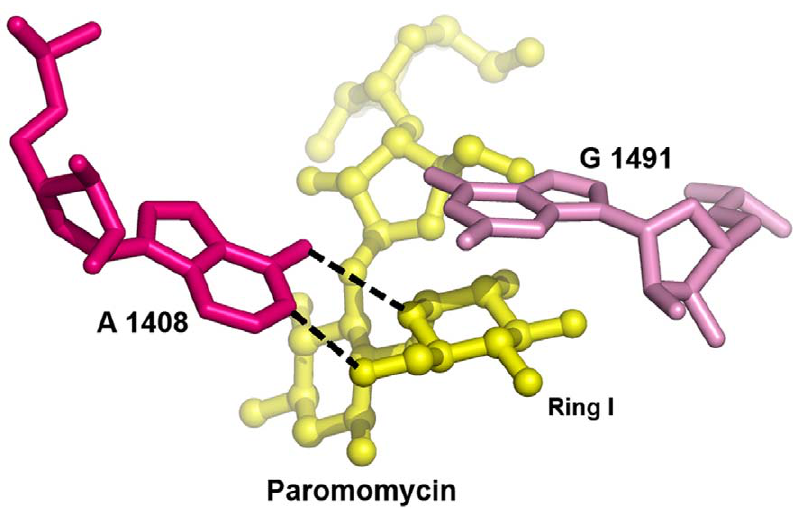
Figure 2. Secondary structure of 16S rRNA helix 44 in the ribosomal decoding site. ( A ) Decoding site of E. coli wild-type (Proteobacteria). Four nucleotide positions depicted in green represent residues that are specific for E. coli 16S rRNA. ( B ) Decoding site of M. smegmatis wild-type (Mycobacteria). ( C ) Decoding site of M. smegmatis mutagenised to correspond to the polymorphism observed in E. coli i.e., Eco4.